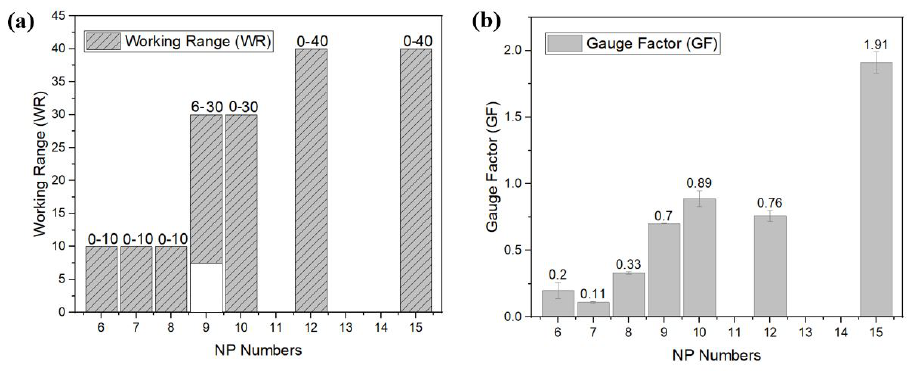
Figure 6. The effect of NP values on the sensor performance for the series of NP x Y S range, and ( b ) gauge factor.